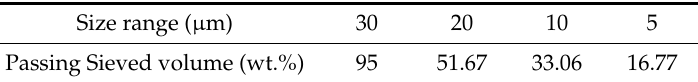
Table 2. Particle size distribution of fly ash.